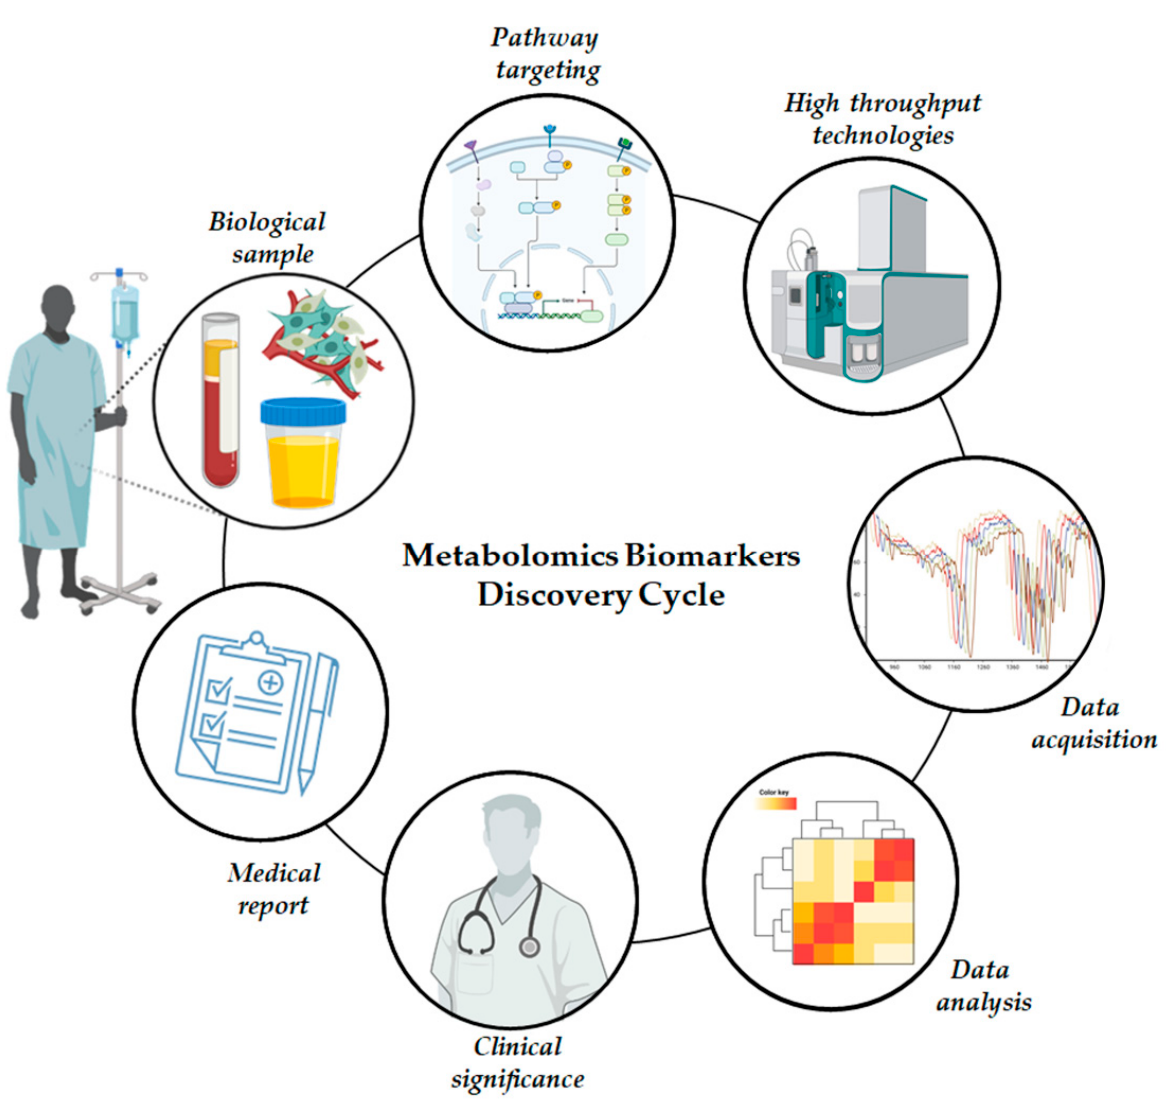
Figure 2. Metabolomics biomarkers’ discovery cycle: from the biological sample, to the identification of the disturbed metabolic signaling pathways, to its clinical significance. Metabolomics results facilitate the integration of the metabolic profile in the pathophysiology of prediabetes.